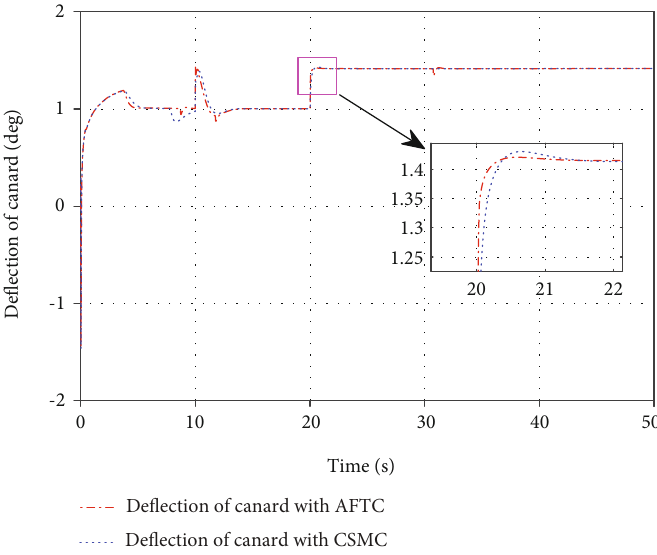
Figure 4: De fl ection of canard control surface in the presence of elevator fault in scenario